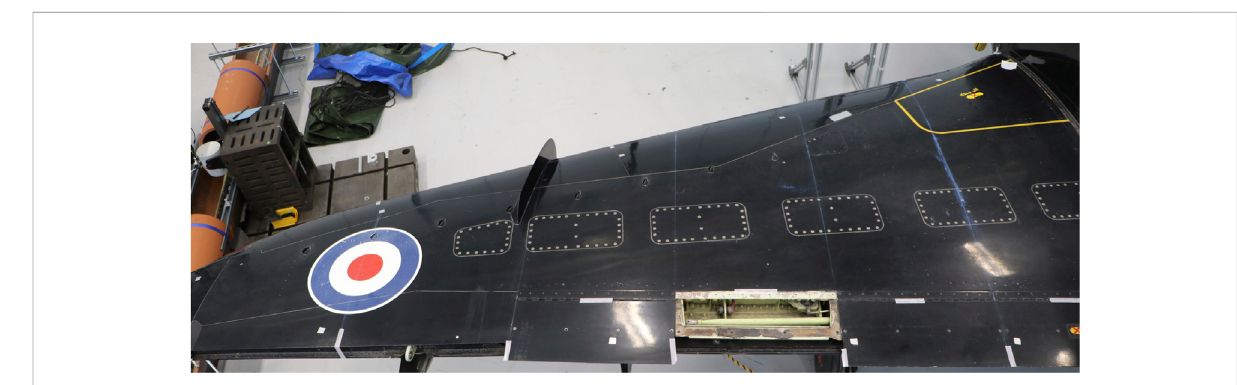
FIGURE 6 Top down view of the right wing of the Hawk T. Mk1 at the Laboratory for Veri fi cation and